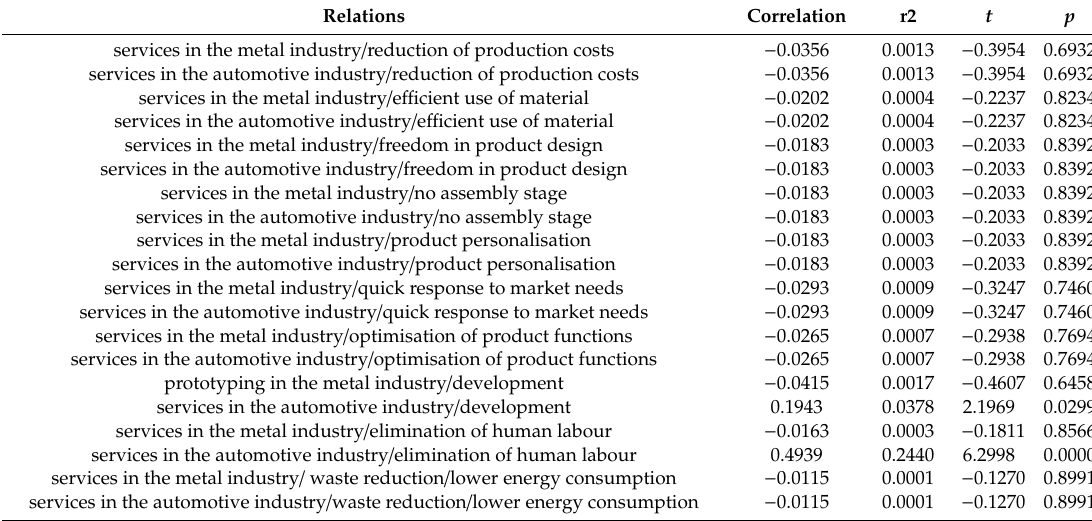
Table 5. Correlation analysis: